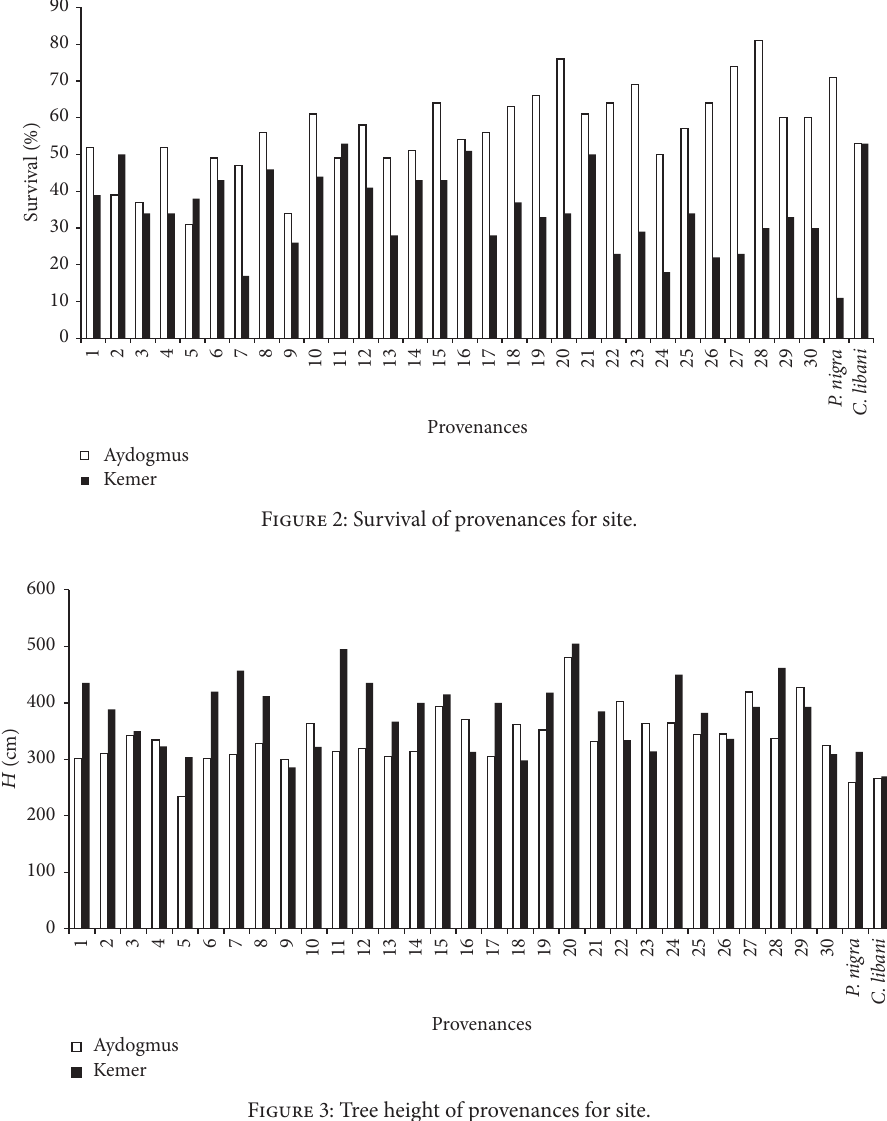
Figure 3: Tree height of provenances for